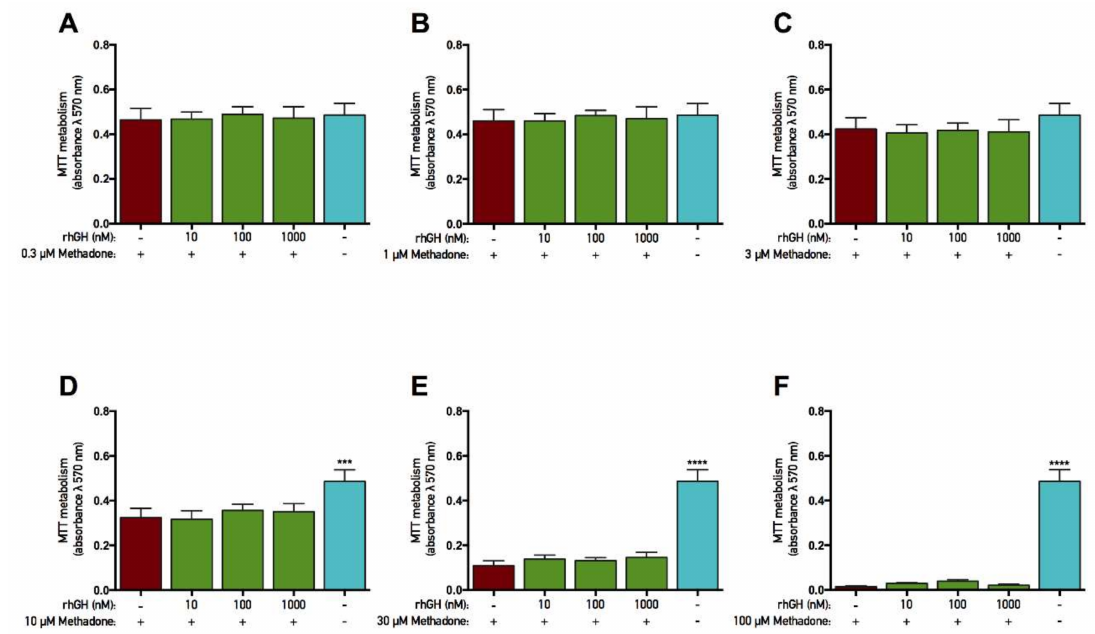
Figure 4. No protective effects of recombinant human growth hormone on mitochondrial function were found when co-treated with methadone. Mitochondrial function was assessed by tetrazolium bromide (MTT) assay. Recombinant human growth hormone (rhGH) was added with methadone for three consecutive days prior to analysis. ( A ) Effects of 0.3 µ M with or without 10–1000 nM rhGH. There were no differences between groups. ( B ) Effects of 1 µ M methadone with or without 10–1000 nM rhGH. There were no differences between groups. ( C ) Effects of 3 µ M methadone with or